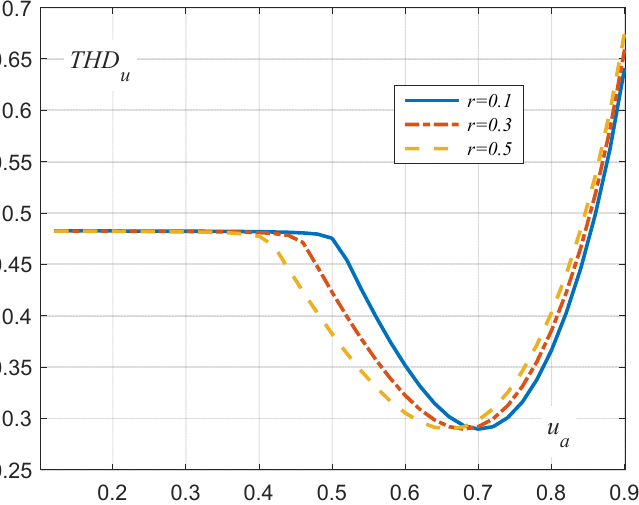
Figure 8. Harmonic content coefficient of load voltage THD u as a function of load voltage amplitude and circuit resistance.